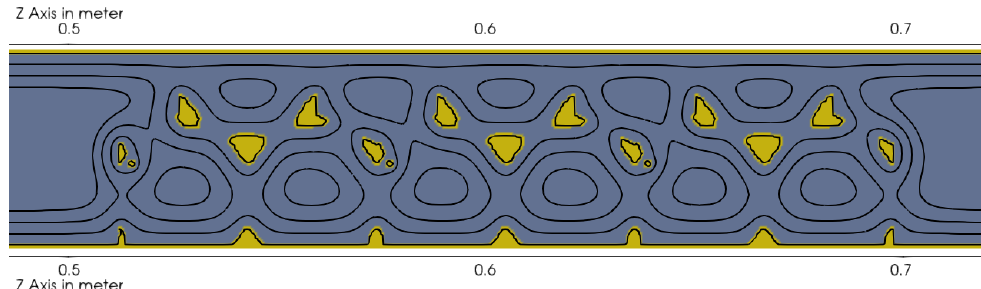
Figure 7. Contour lines on the light distribution. Yellow parts are light sources and the algae suspension is colored blue.